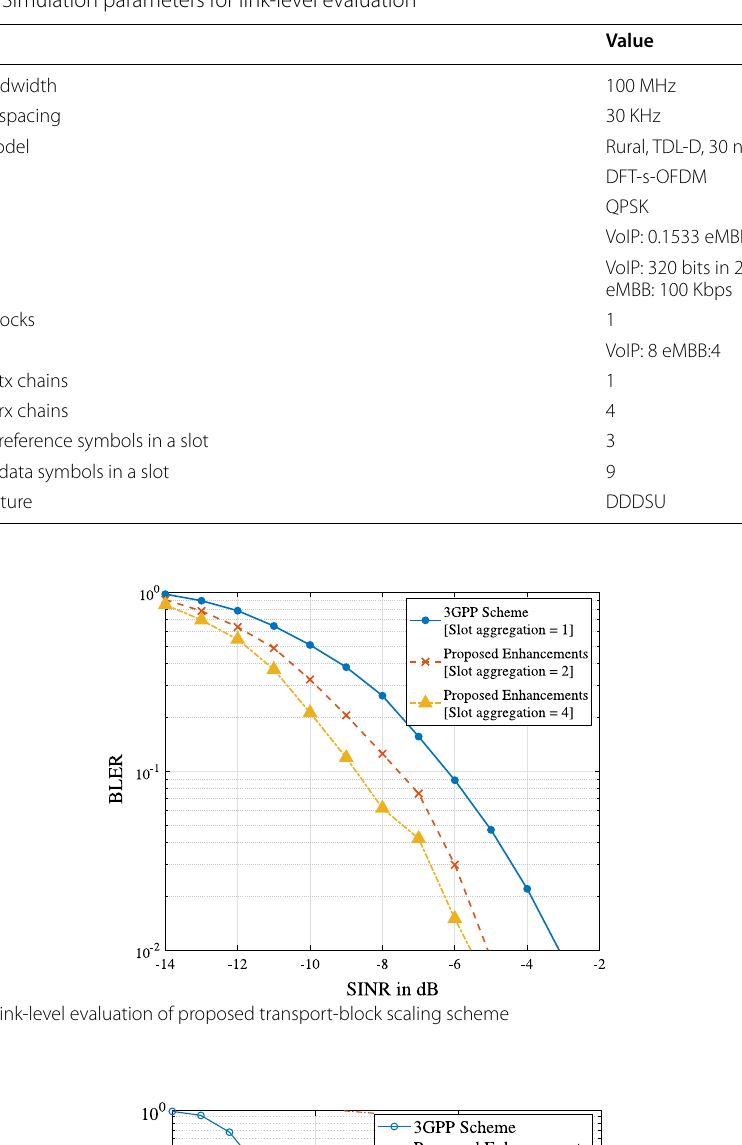
Table 10 Simulation parameters for link-level evaluation